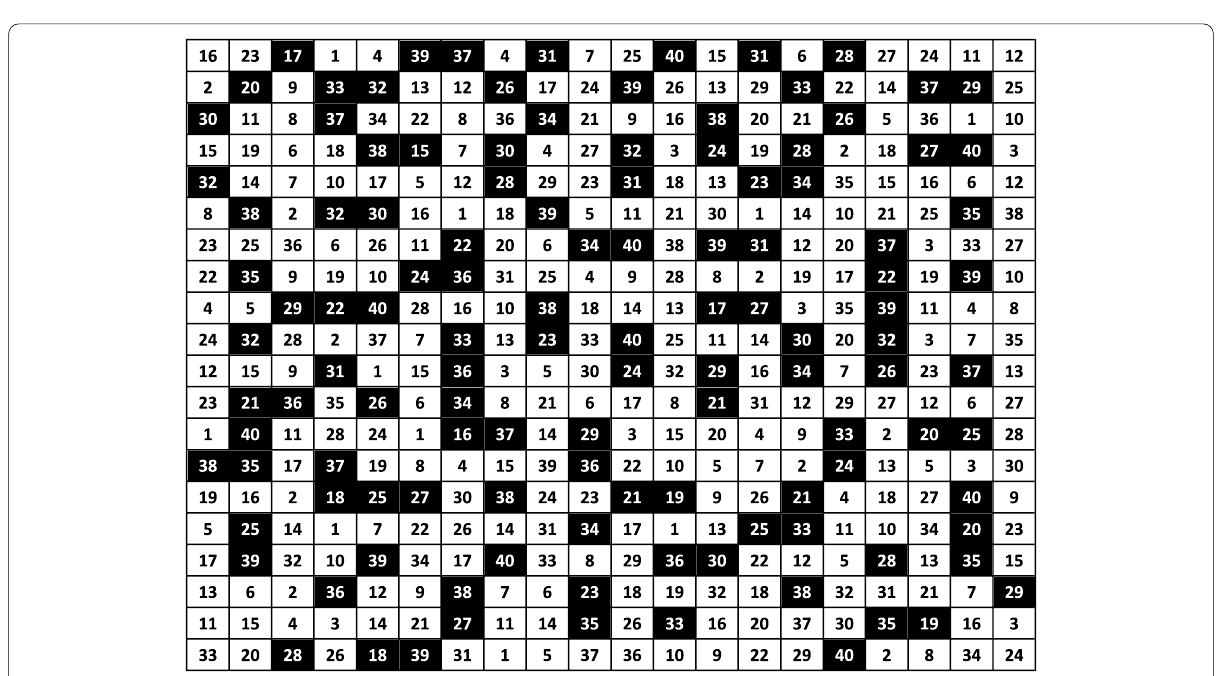
Fig. 5 The ONA seed orchard layout with 30% genetic thinning (black cells) following the Linear Deployment (ONA, GTL